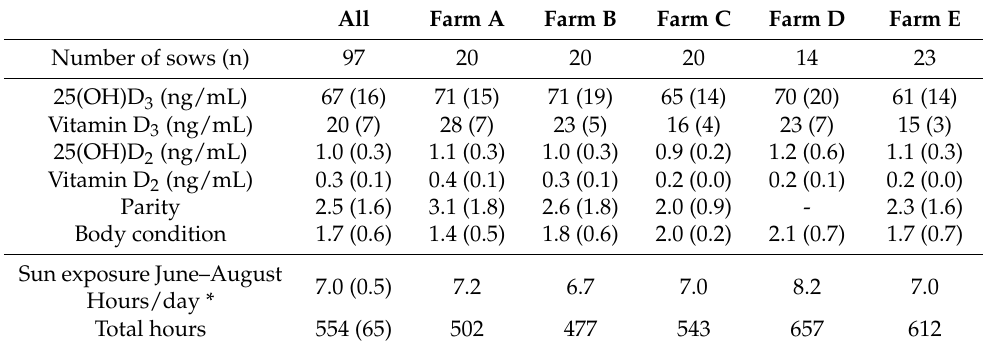
Table 1. Number of sows from each farm (A–F), mean values and standard deviations for 25(OH)D 3